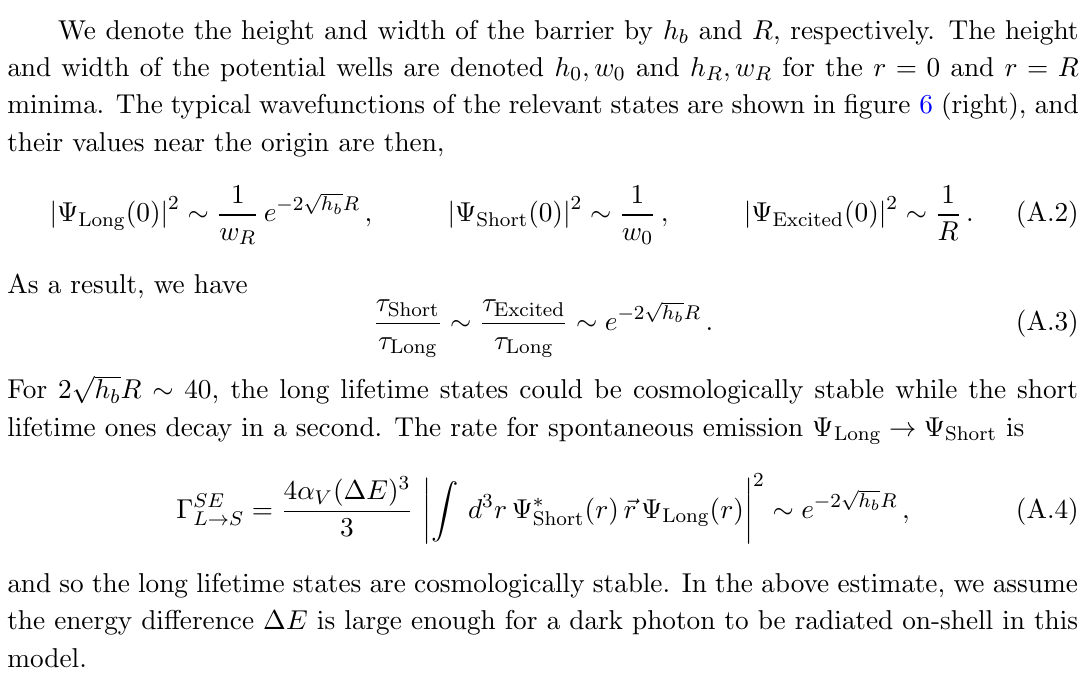
Figure 6 . An illustration of tunneling Stabilization. Left : The potential and energy eigenvalues. Right : Sample wavefunctions. The coordinate r is in unit of m − 1 and the bound state wavefunctions are in unit of m 3 / 2 χ of m χ